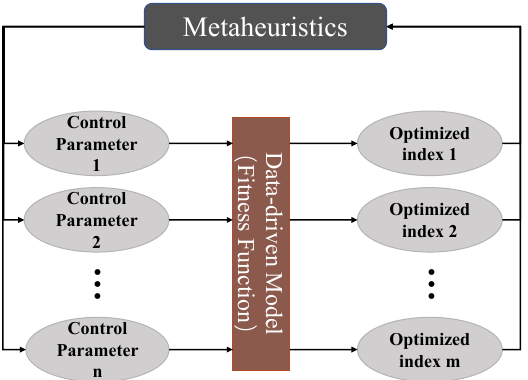
Figure 2. Illustration of the data-driven metaheuristic